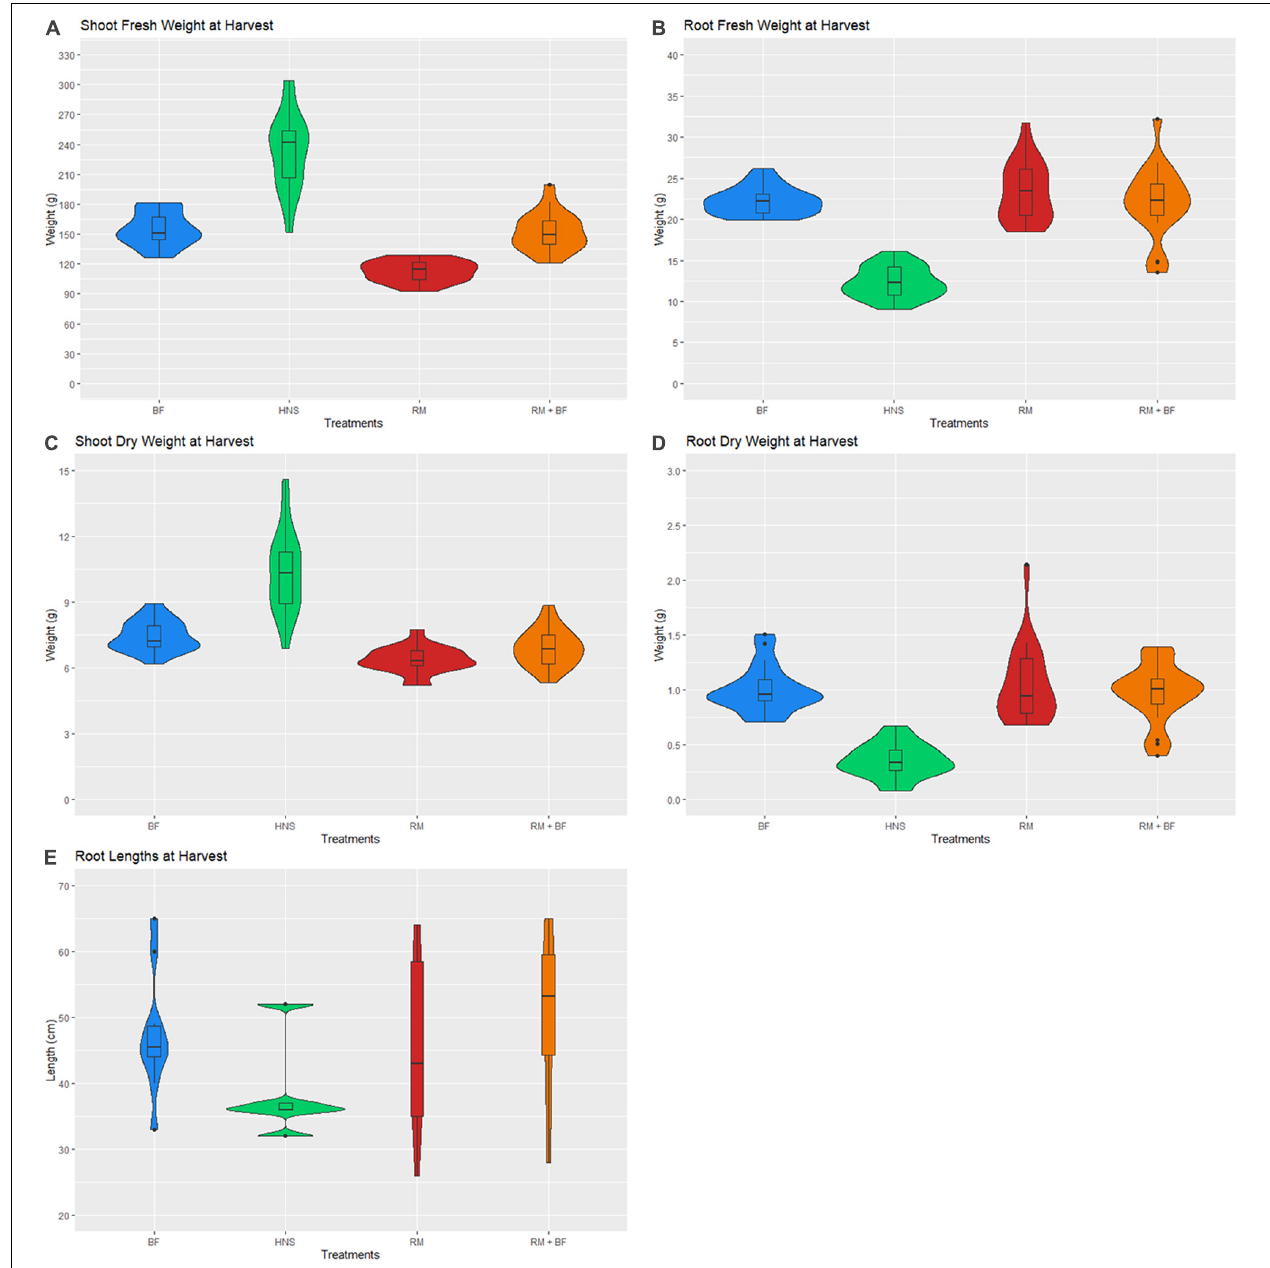
FIGURE 10 | Lettuce head fresh (A,B) and dry (C,D) weights for shoots and roots at harvest. Root lengths are depicted in (E)